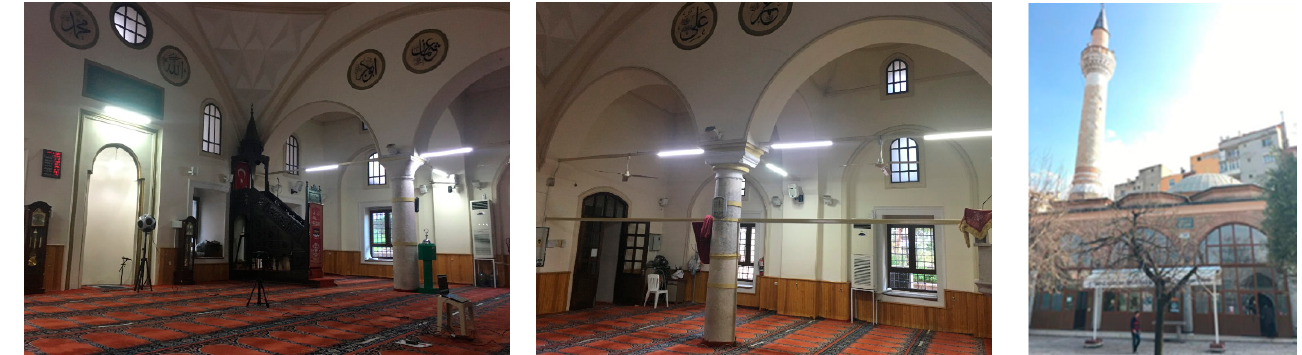
Figure 4. Main prayer hall and side section of Çe ş nigir Mosque (photos by the authors) .